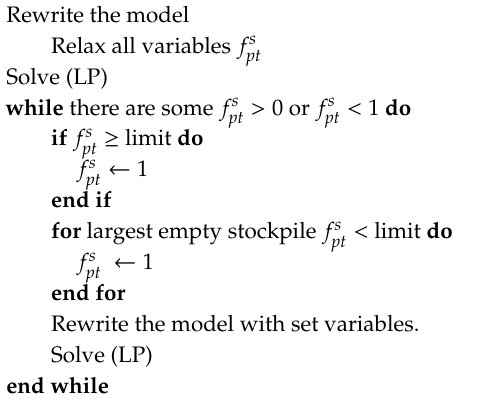
Algorithm 1 Setting binaries variables for stacking a stockpile Algorithm 1. Setting binaries variables for stacking a stockpile. Rewrite the